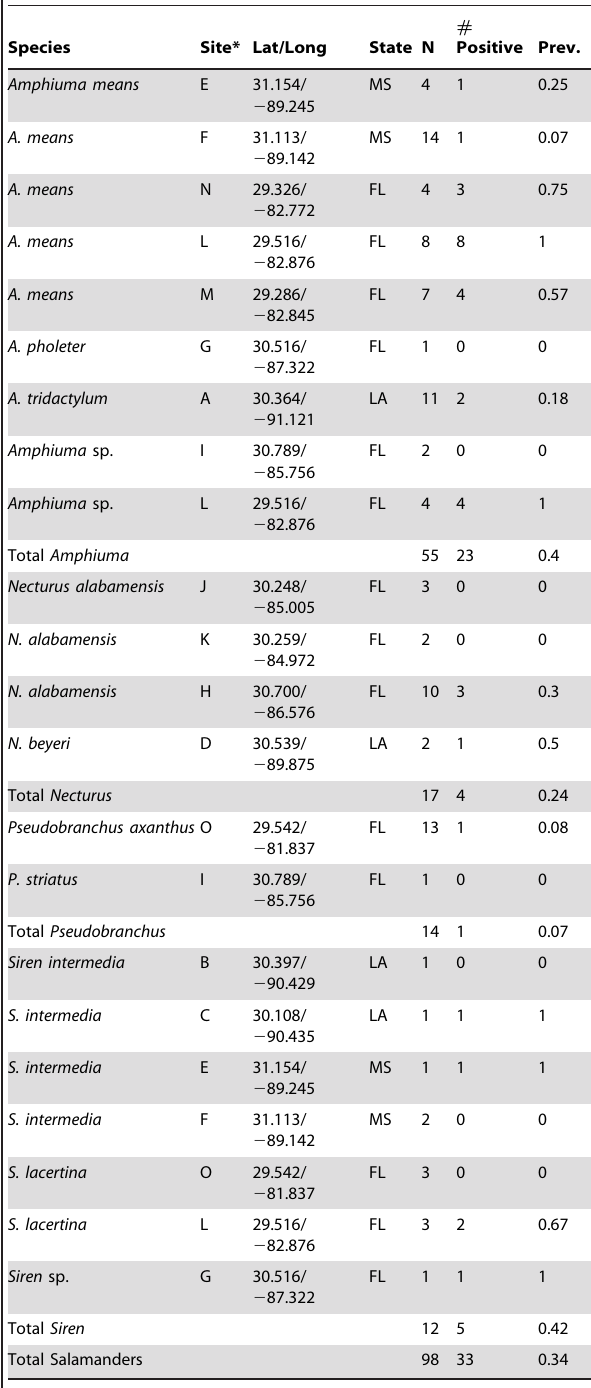
*Sites correspond to those given in Figure 1.